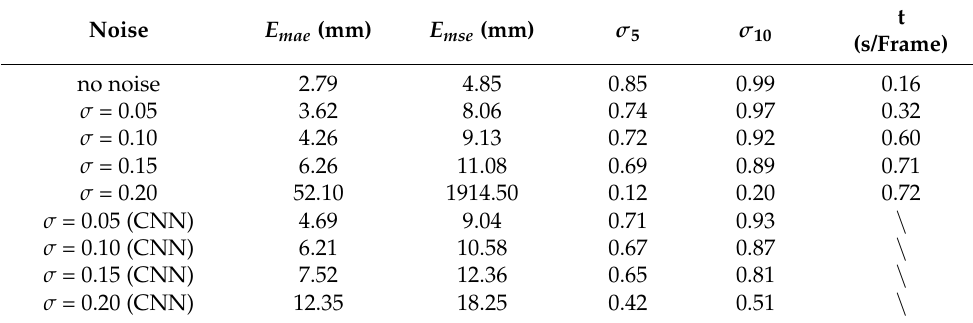
Table 3. Error indicators